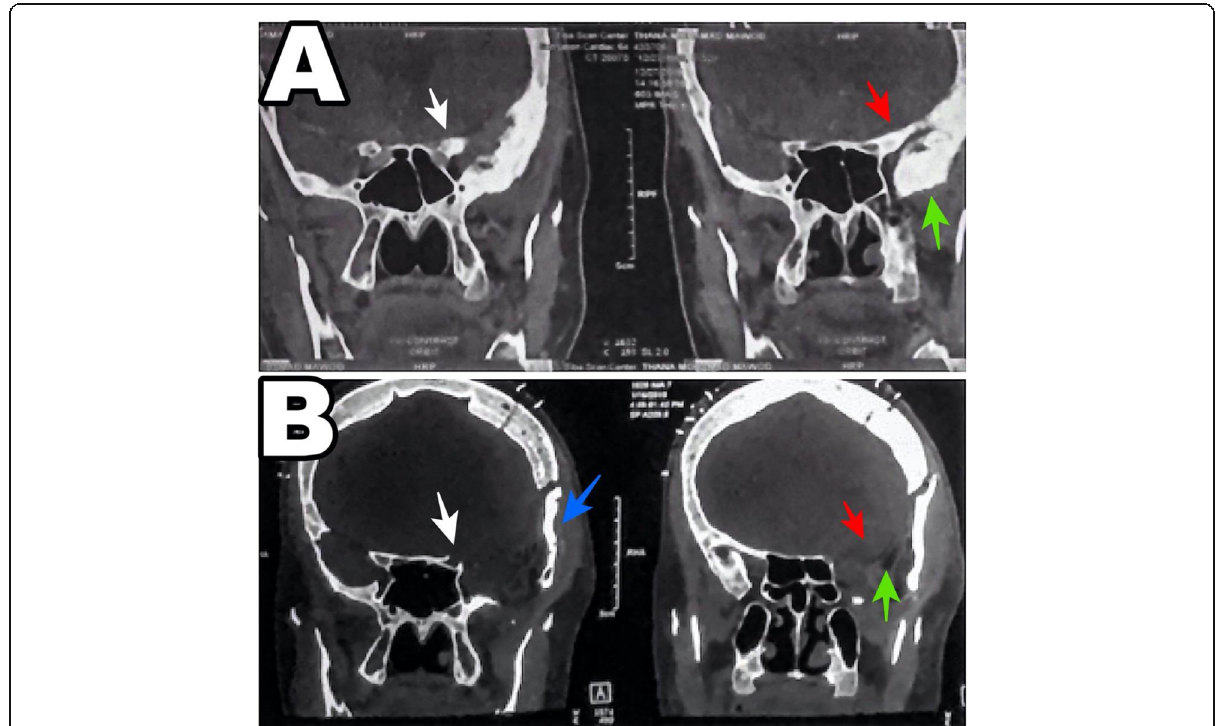
Fig. 1 Left side SOM, coronal CT scan before and after